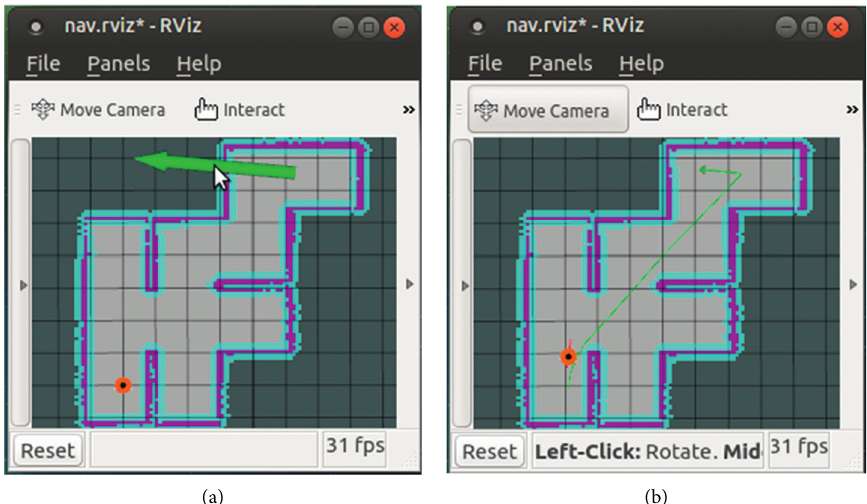
Figure 8: Simulation result of path planning. The green arrow on the left picture means the orientation of the robot when it reaches the end.